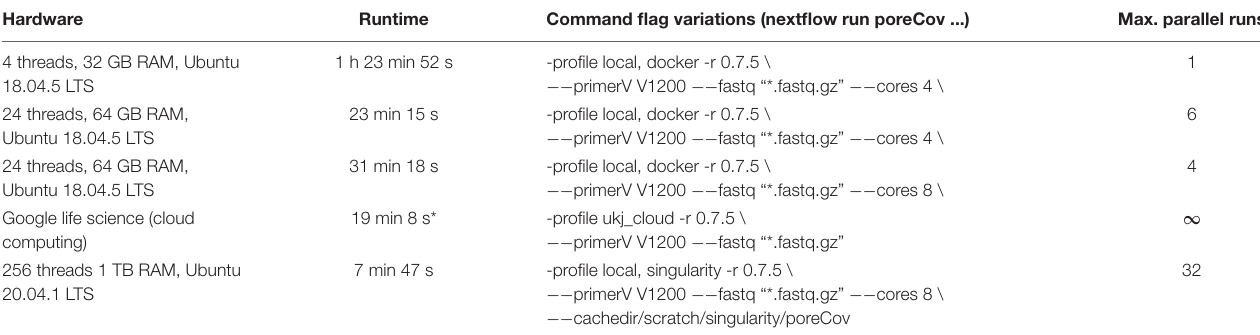
TABLE 2 | poreCov time to results (runtime of the workflow starting from fastq files to the final report) for different hardware configurations using 10 read files as input (fastq files). Hardware Runtime Command flag variations (nextflow run poreCov